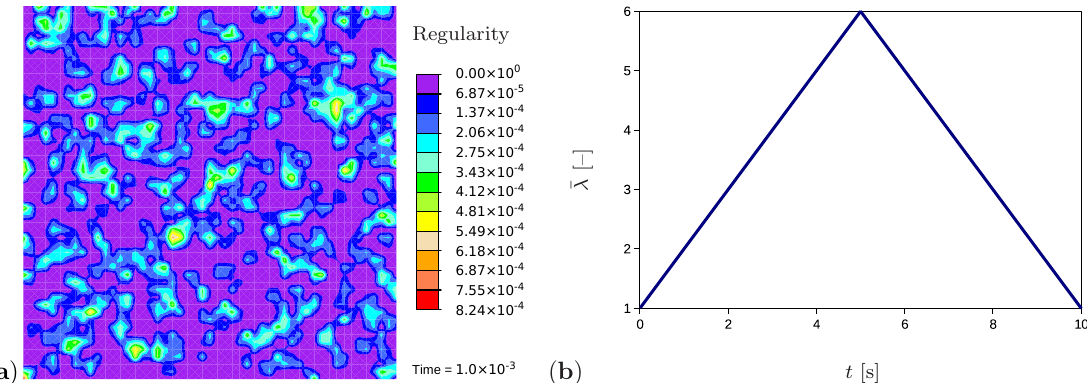
Figure 8. ( a ) Initial microstructure with randomly distributed nuclei. ( b ) The applied stretch as a function of time.